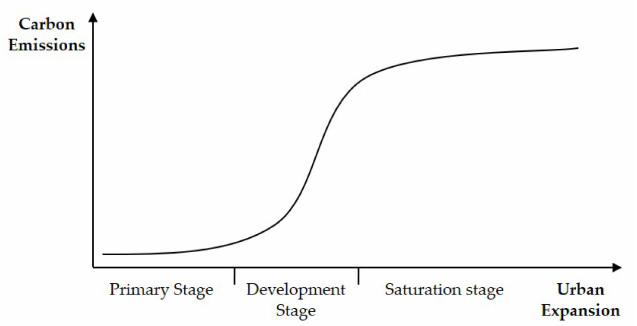
Figure 5. Logistic curve of urban expansion and carbon emission.